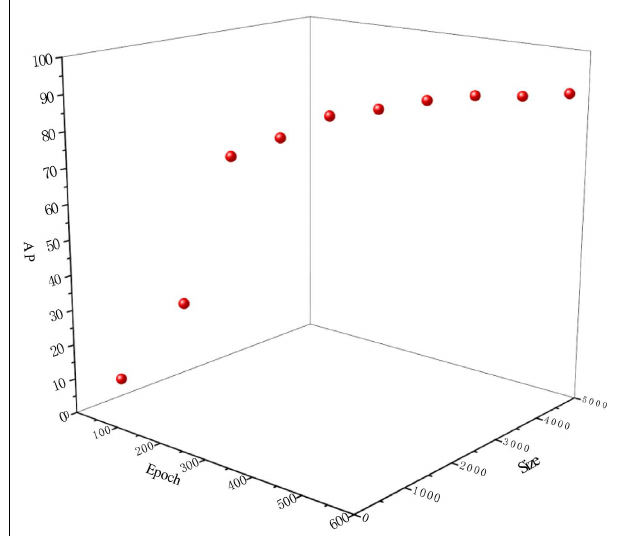
FIGURE 5 | Impact of dataset size and epoch time on